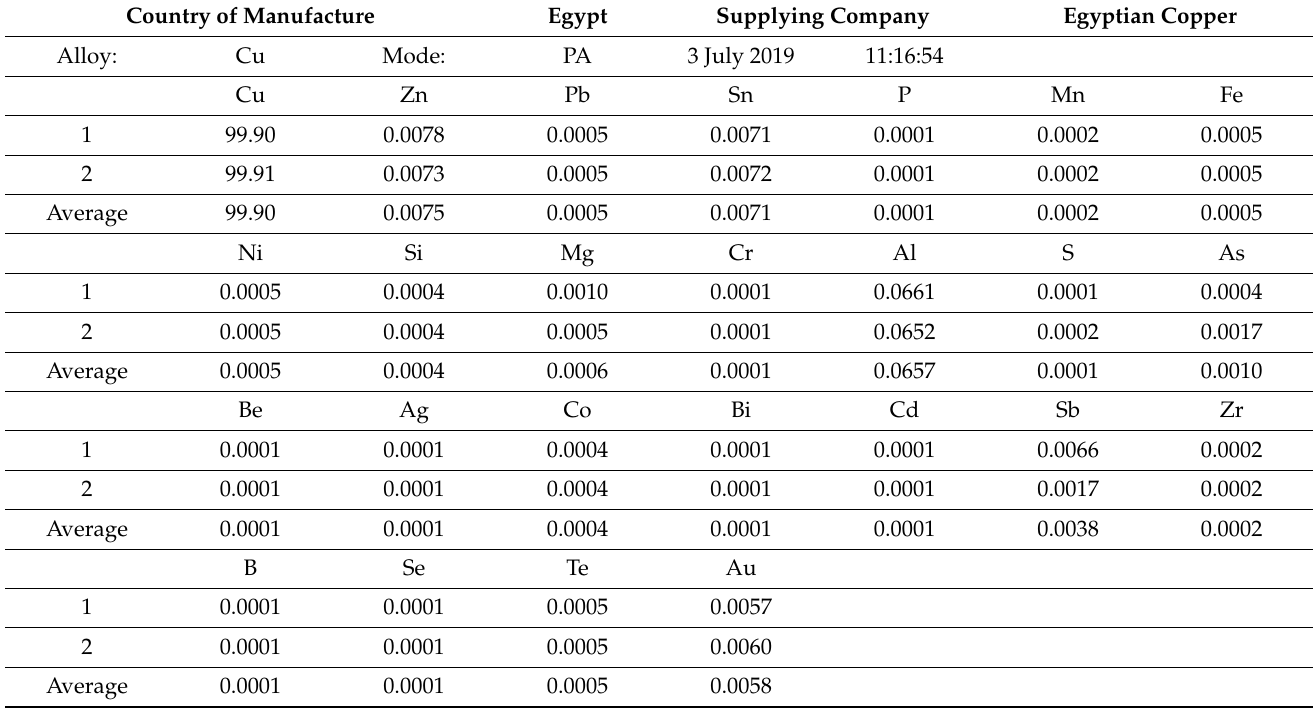
Table 1. Chemical composition of the copper used in the cutting path of the experimental